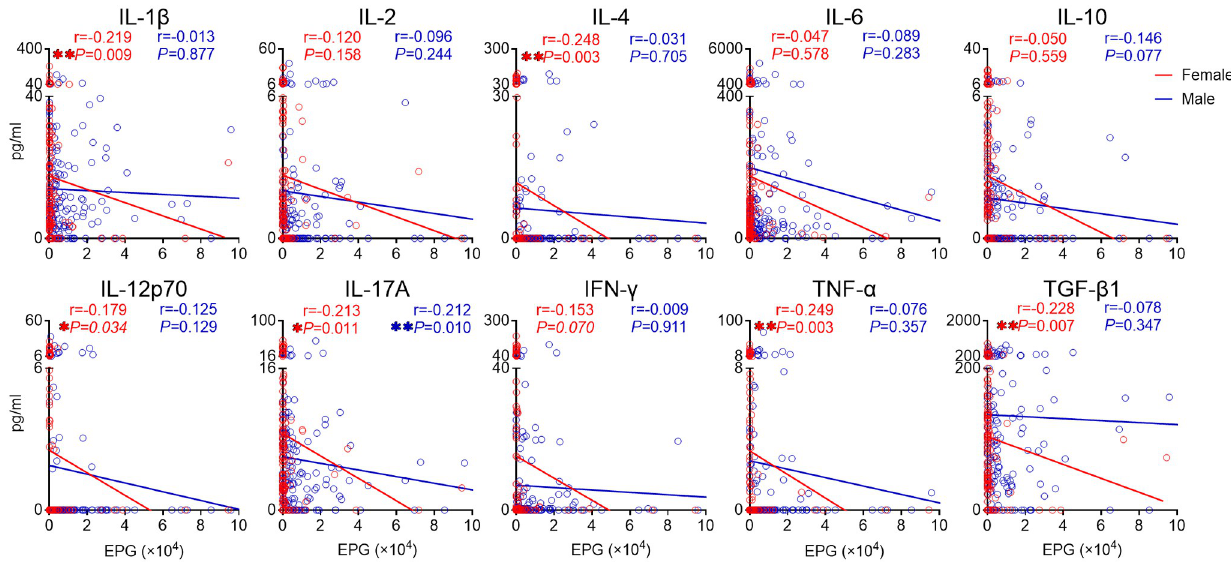
Fig 4. Spearman’s correlation analysis between EPG and serum levels of cytokines in female and male groups. Spearman’s correlation analysis between EPG and serum levels of IL-1 β , IL-2, IL-4, IL-6, IL-10, IL-12p70, IL-17A, IFN- γ , TNF- α and TGF- β 1 in female (n = 141) and male (n = 148). EPG: eggs per gram of feces. The data were shown as the mean ± s.e.m., � P < 0.05, �� P < 0.01, Spearman’s correlation test.